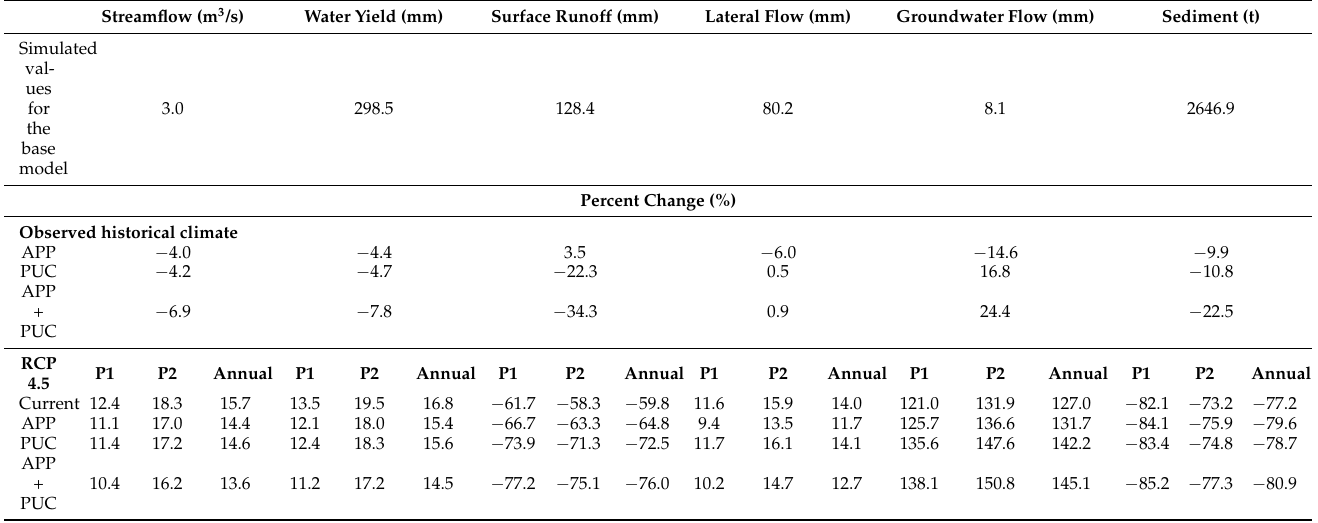
Table 5. Percentage change in the average annual streamflow; water yield; surface runoff; lateral flow; groundwater flow; sediment for land use land cover (LULC) change scenarios and future climate scenarios compared to the mean annual parameter values simulated for the base model (current land use and the observed historical climate time series—years 2012 to 2019). P1 corresponds to the average for the years 2020 to 2053; P2 corresponds to the average for the years 2054 to 2095; “Annual” corresponds to the average for the entire projection period (2020 to 2095). APP = Riparian restoration; PUC = focal conservation; APP + PUC = combined